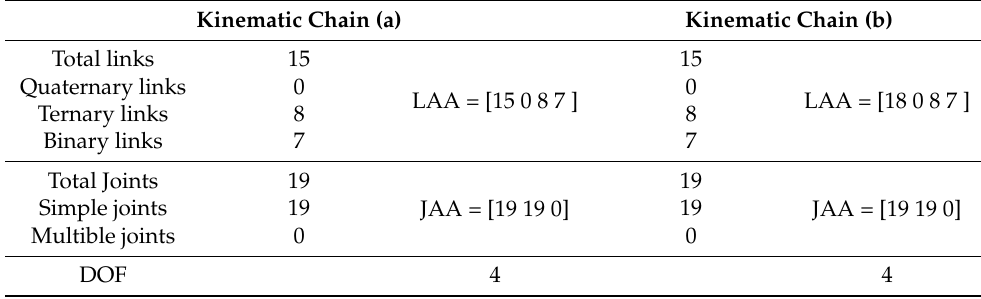
Table 8. Link Assortment Array and Joint Assortment Array for kinematic chains in Figure 13.